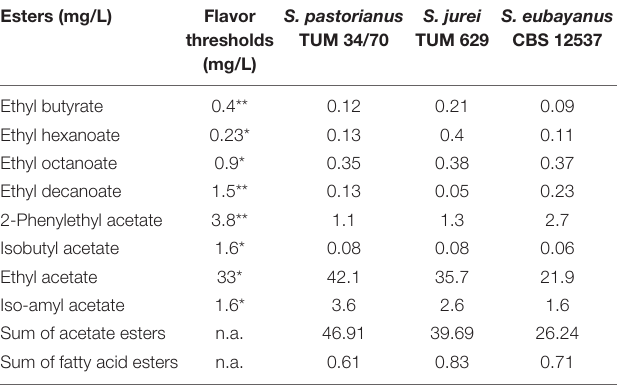
TABLE 4 | Esters detected in the three different beer samples fermented by S. pastorianus (TUM 34/70), S. jurei (TUM 629) and S. eubayanus (CBS 12537) at a fermentation temperature of 15 ◦ C and an original gravity ◦ 12 P.